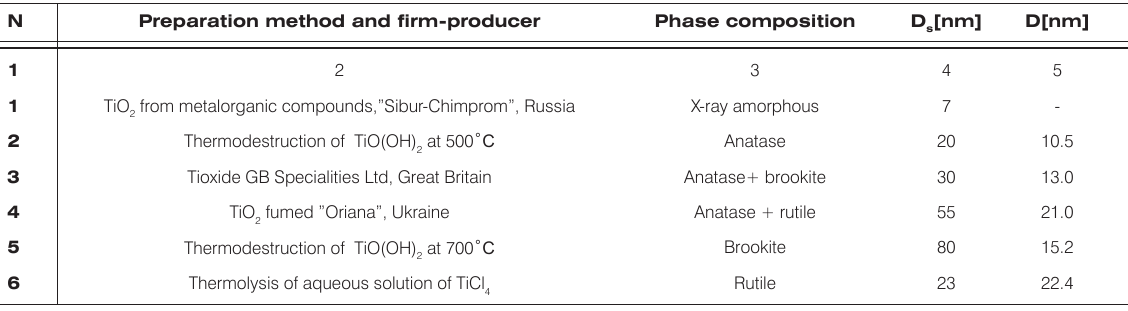
Table 1. Preparation methods and characteristics of initial titanium dioxide samples.